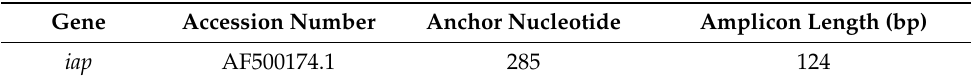
Table 1. Specific amplicon context sequence used in the quantitative PCR (qPCR) assay (PrimerDe- sign™ Ltd., Rownhams, UK). For proprietary reasons, the primer/probe sequences cannot be disclosed, but the details provided are compliant with the minimum information for publication of quantitative real-time PCR experiments according to Bustin et al. (2011)